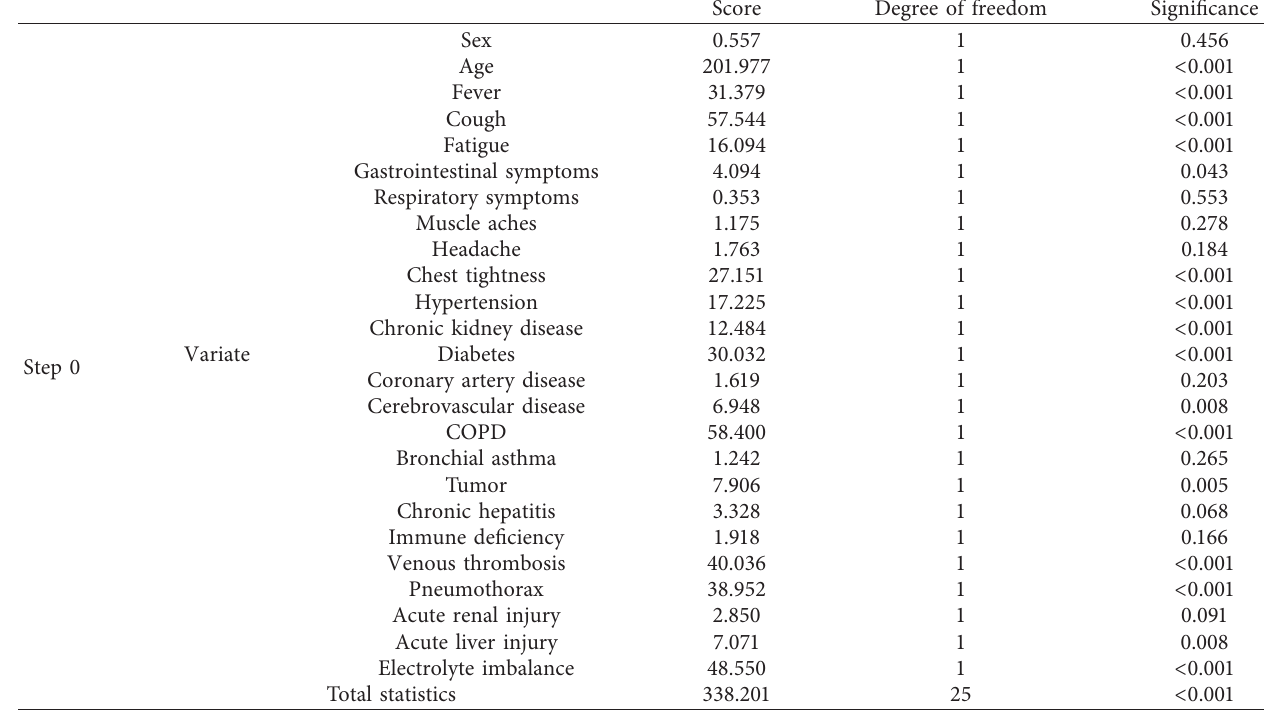
Table 1: Comparison of clinical symptom indices between common and severe COVID-19 patients at admission.